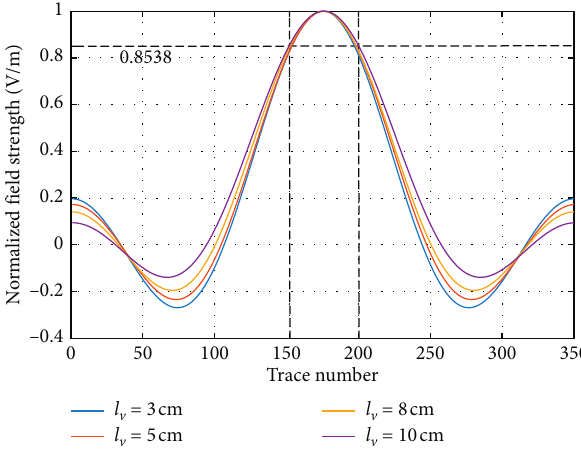
Figure 8: Void echo space distribution in sample number � 878. Figure